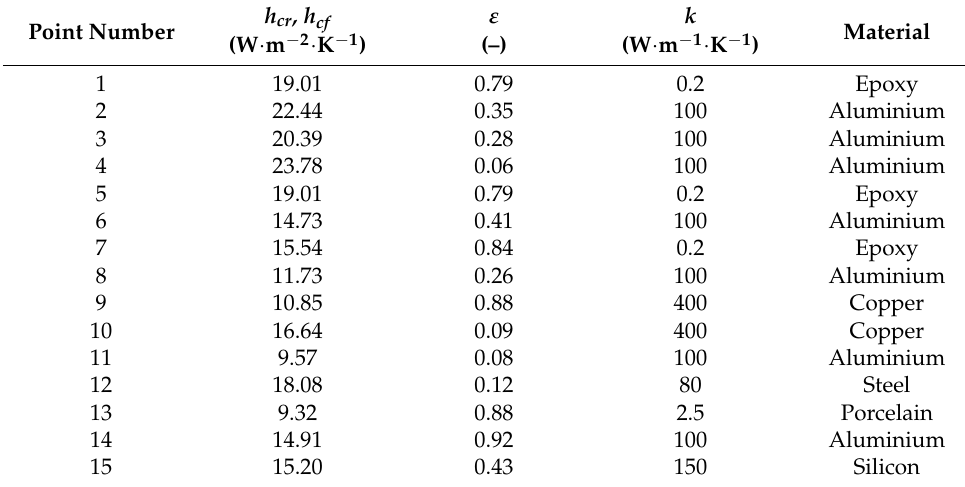
Table 4. Values of the convection coefficient for cylinder h cr , convection coefficient for the flat surface h cf , the value of emissivity coefficient ε , thermal conductivity value, and selected material used in the simulation, where the power dissipated on the P j junction was 9.91 W ( ∆ P j = 0.71 W).